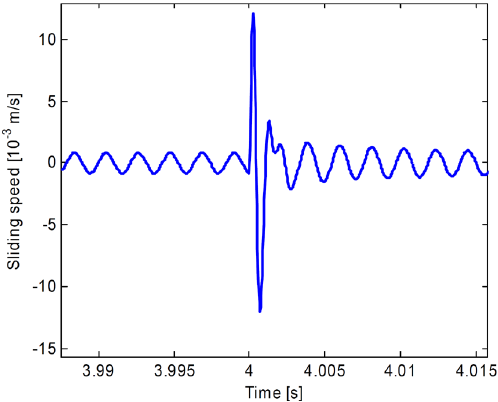
Figure 16. Sliding speed predicted using Dahl model.